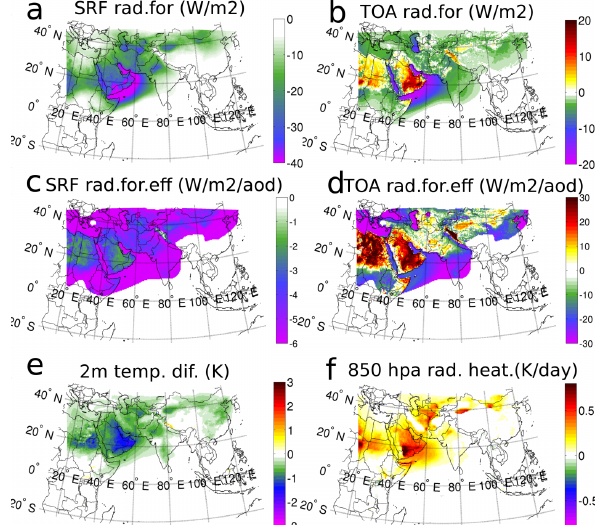
Figure 10. (a) JJAS 2000–2009 dust aerosol surface radiative forc- ing diagnostic. (b) JJAS 2000–2009 dust top-of-atmosphere radia- tive forcing diagnostic. (c and d) Corresponding surface radiative forcing efficiencies. (e) JJAS 2000–2009 2m temperature difference between dust and nodust simulations. (f) 850hpa radiative heating rate difference between dust and nodust simulations. All modeling results represent a three-ensemble-member